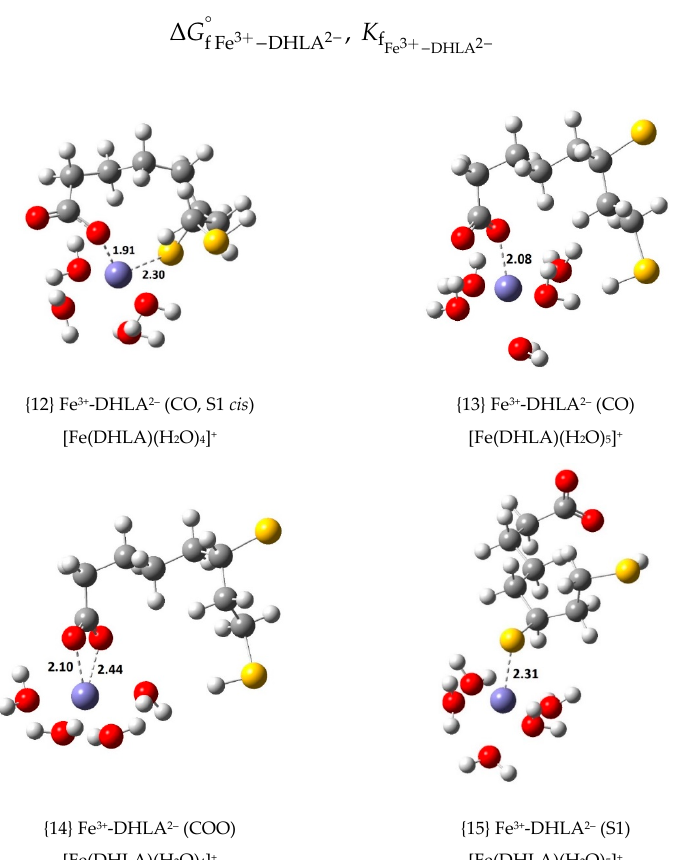
Figure 4. Optimized geometries of the 1:1 complexes of Fe(III) with S1-deprotonated DHLA 2 − (bond distances in Å).